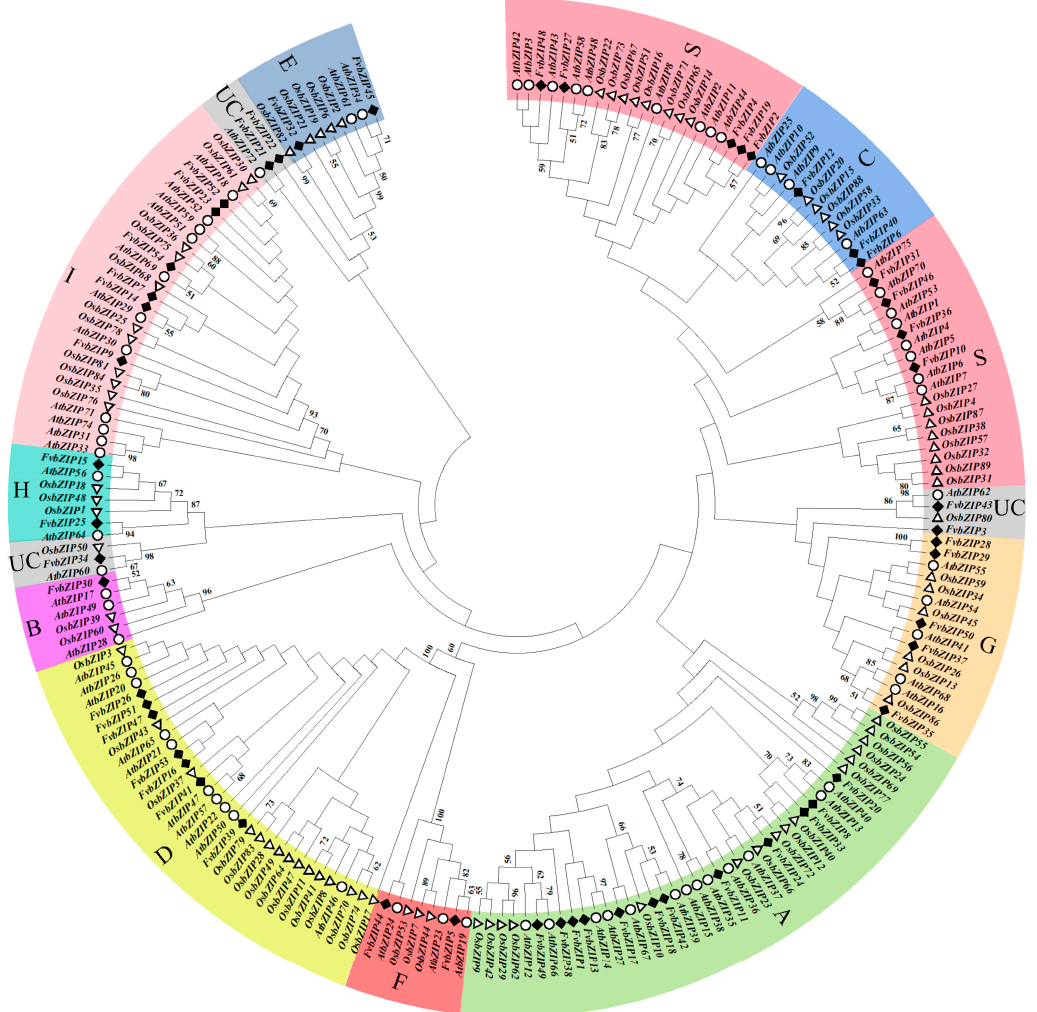
Figure 1. Phylogenetic analysis of bZIP genes. At represented A. thaliana , Os represented O. sativa . The phylogenetic tree was generated using the amino acid sequences of selected bZIP genes via NJ methods. All strawberry bZIP genes, together with their A. thaliana and O. sativa homologues, were classified into 10 groups.